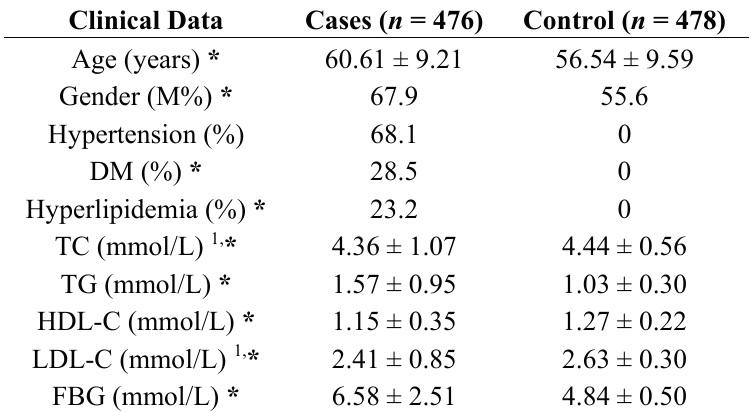
Table 1. Baseline characteristics and risk factors of Coronary Artery Disease (CAD) cases and controls. * p < 0.05 for each clinical indicators, by comparing the control group with CAD group.